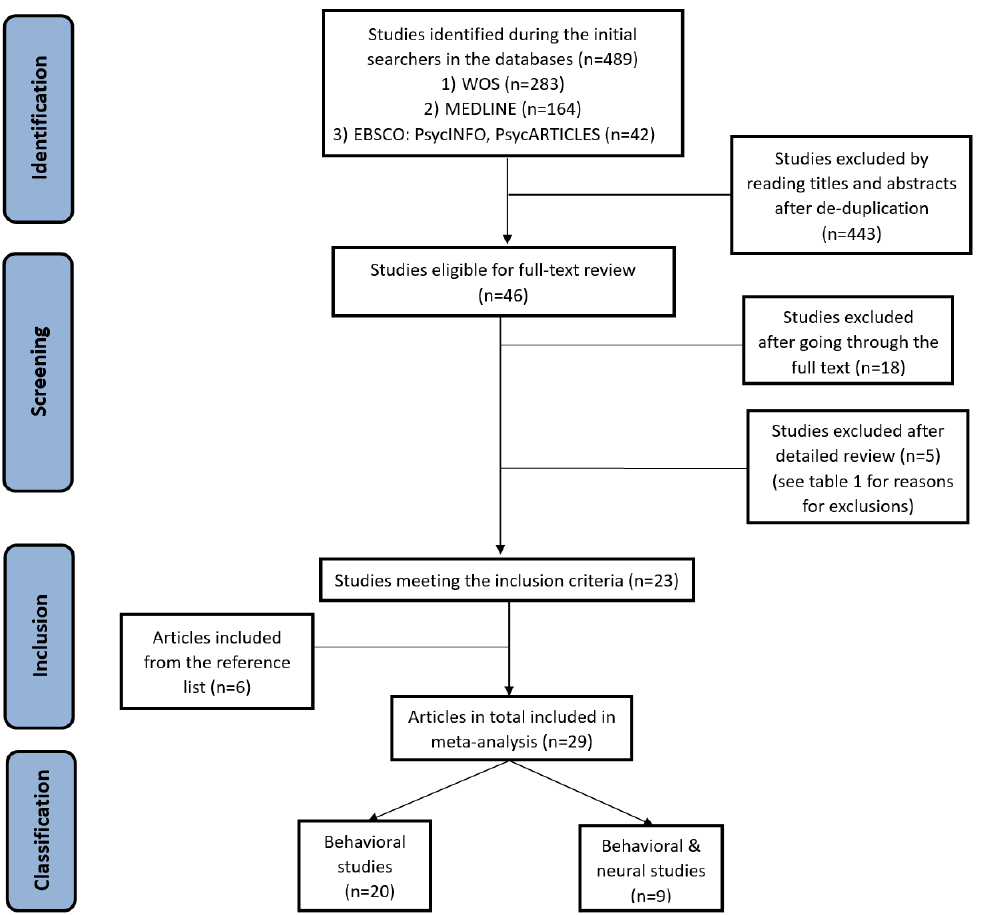
Figure 1. Flowchart of selecting studies for review.